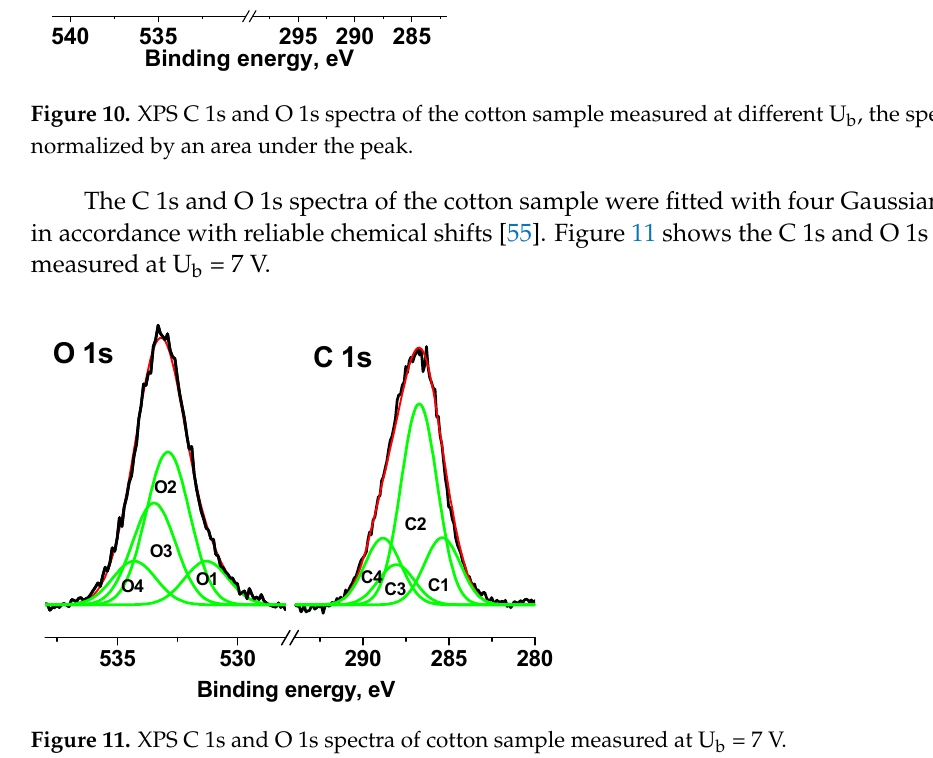
Figure 10. XPS C 1s and O 1s spectra of the cotton sample measured at different U b , the spectra are normalized by an area under the peak.